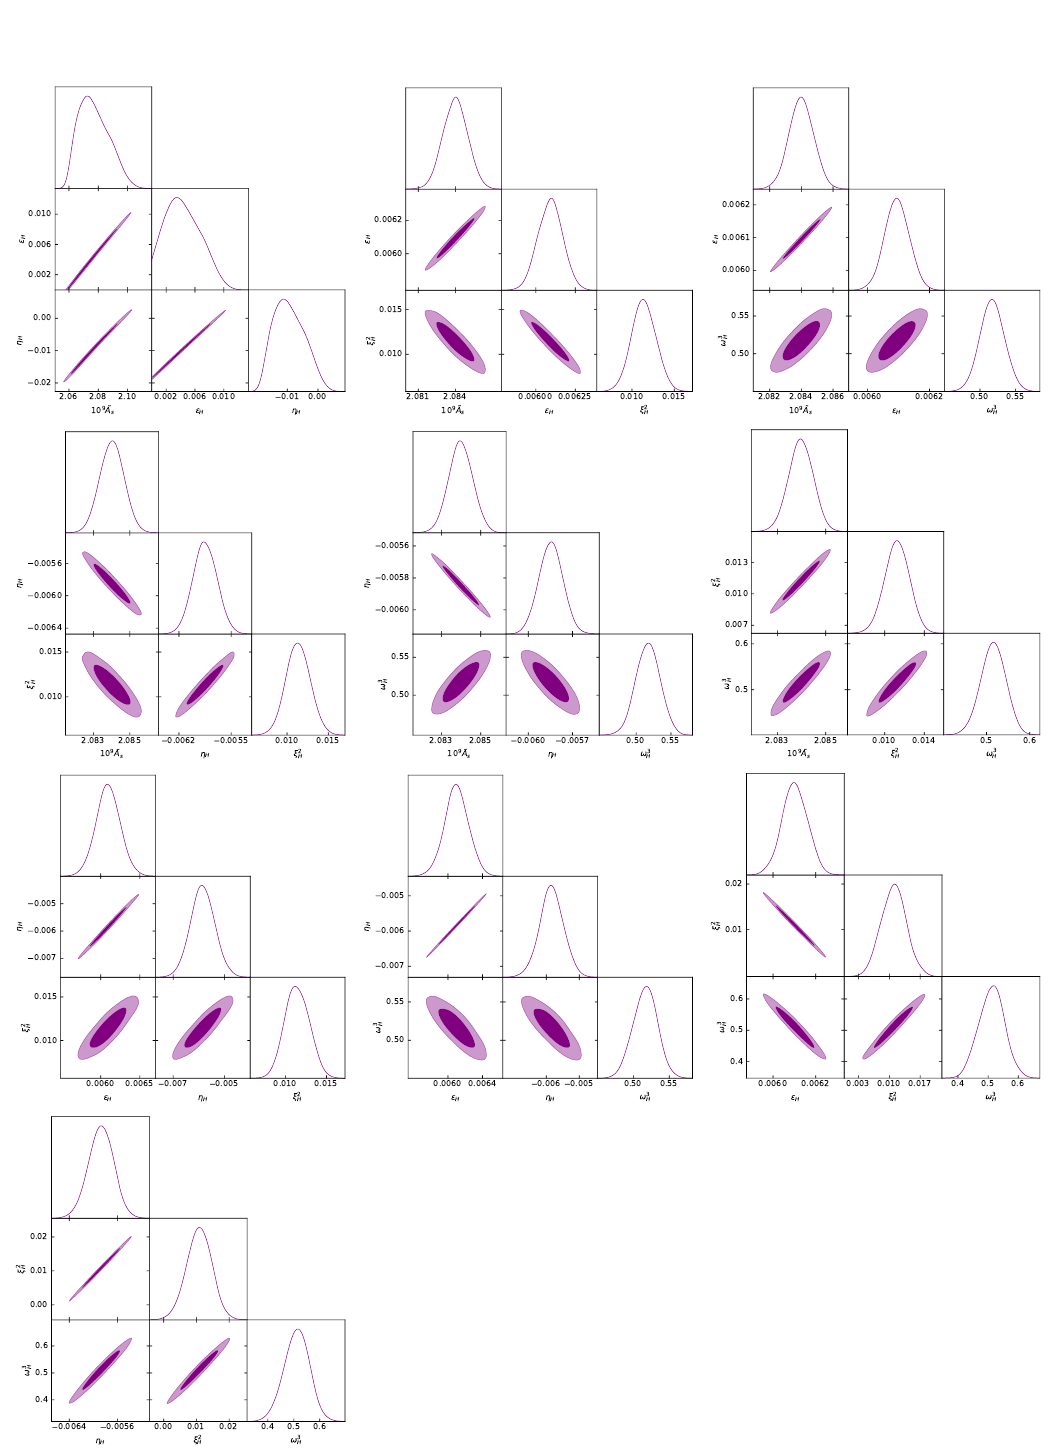
Figure 13: Sliced 3-dimensional likelihoods for the slow-roll parameters from a com- bination of Planck and SKA